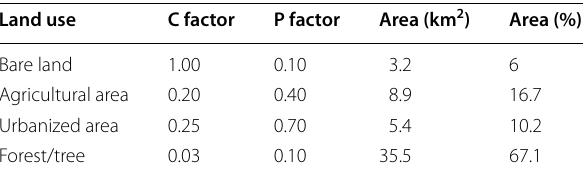
Table 1 P and C factors with recent total area land-use in Chini lake basin area. Source : Department of Irrigation and Drainage of Malaysia (2010), Morgan